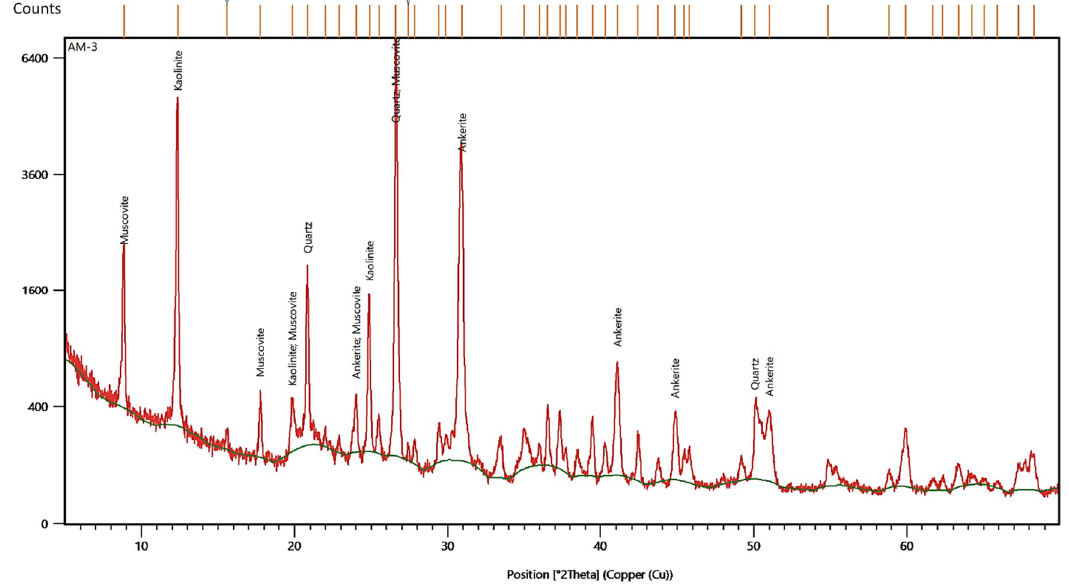
Figure A3. XRD diagram of sample Am 3 (reddish cataclasite).